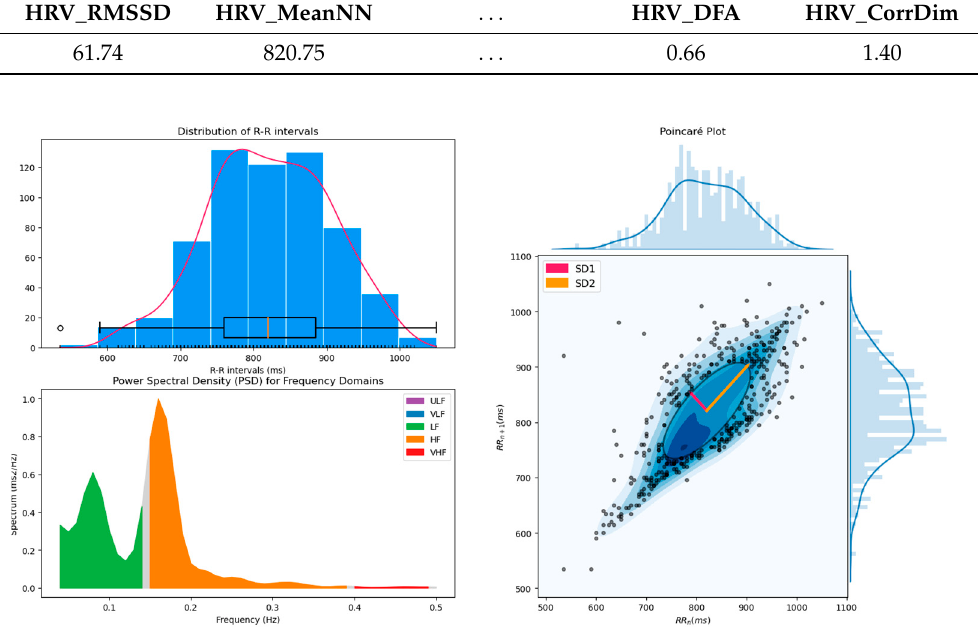
Figure 1. Output of the hrv() function showing the distribution of NN intervals, the power spectrum density (PSD) and the Poincaré plot, that can be used as a visual diagnostic tool for HRV.